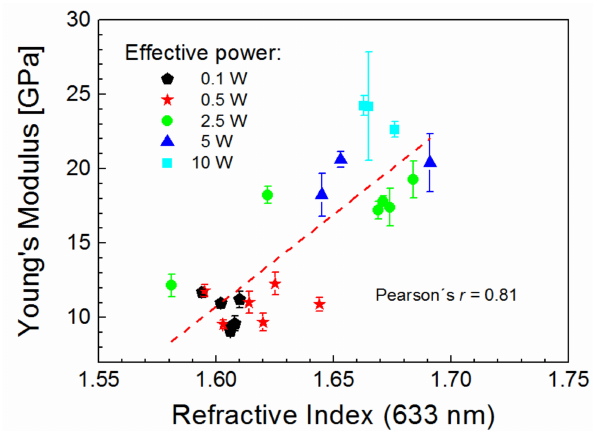
Figure 7. Young’s modulus correlated with the refractive index (633 nm) for oxidized plasma polymer films deposited at different effective power.